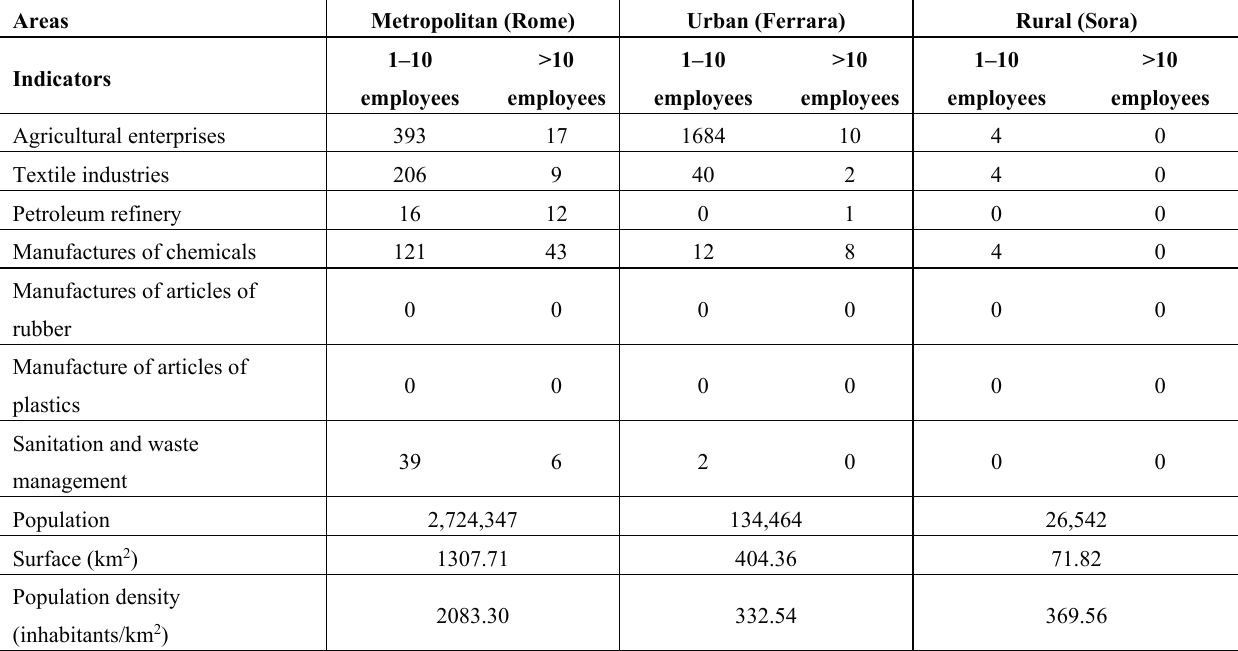
Table 2. Distribution of a set of territorial, demographic and productive indicators in the study areas. Data from the Italian National Institute of Statistics